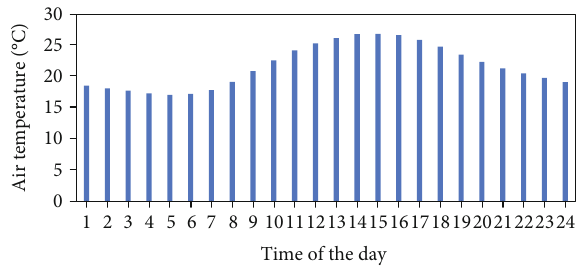
Figure 7: Annual hourly average air